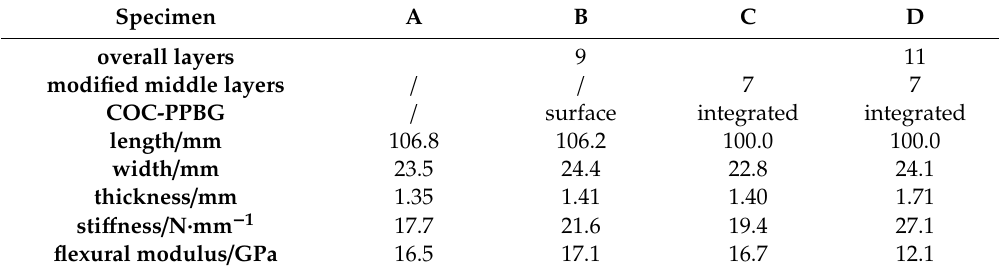
Table 1. Data of cured carbon fiber reinforced polymer (CFRP) specimens.